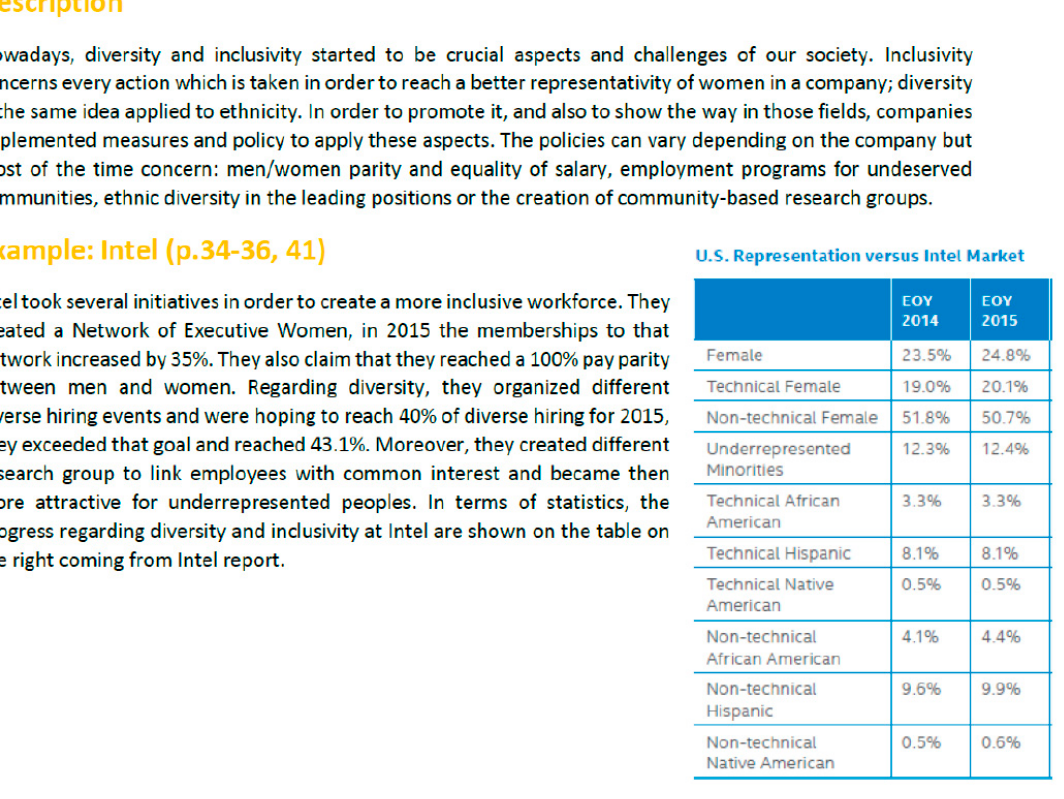
Figure 3. Document referencing LP6: Build a diverse and inclusive workforce.